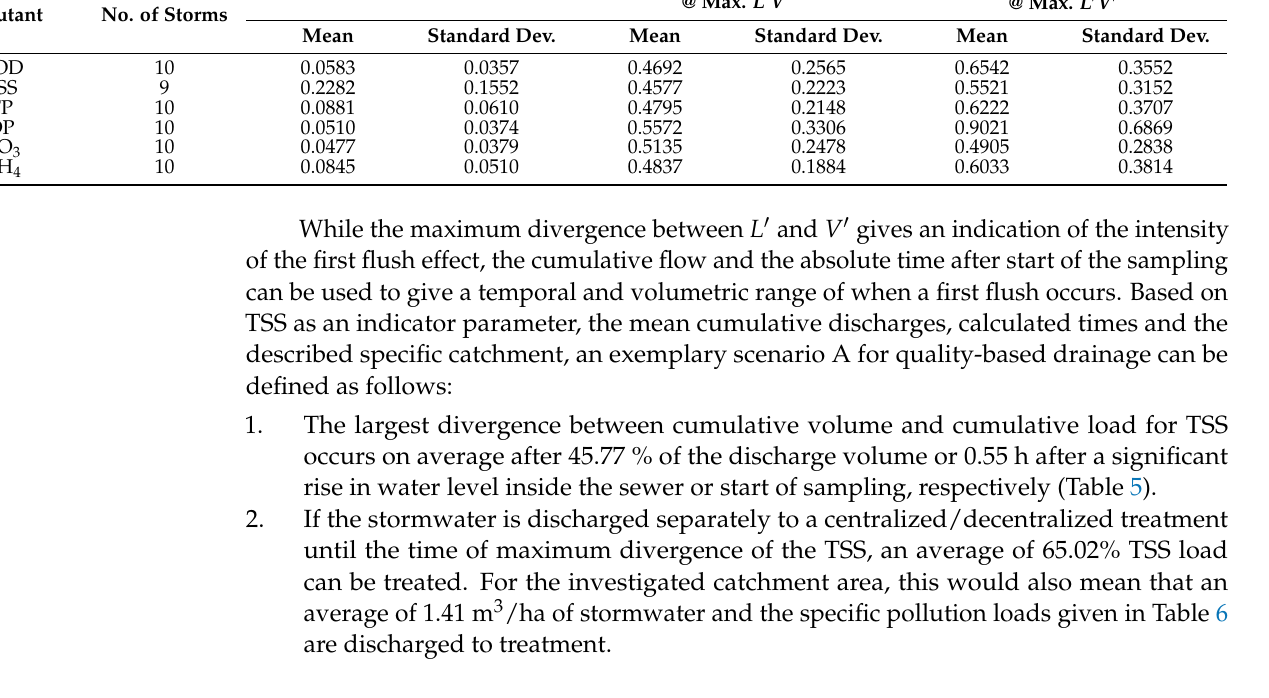
Table 6. Summary of specific volume and pollutant loads for scenario